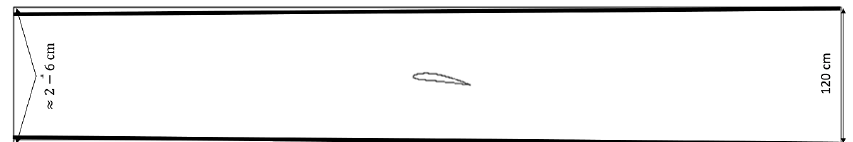
Figure 10. Schematic representation of the linear